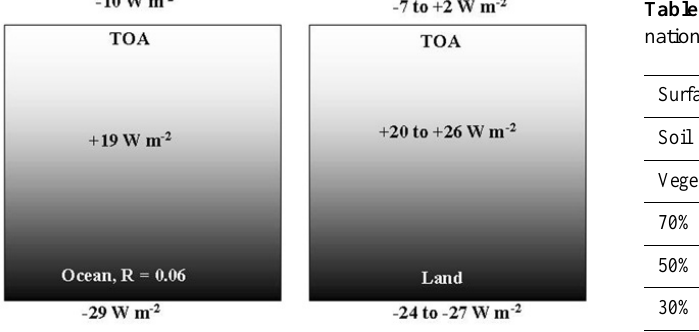
Table 1. Reflectance of different types of surfaces and their